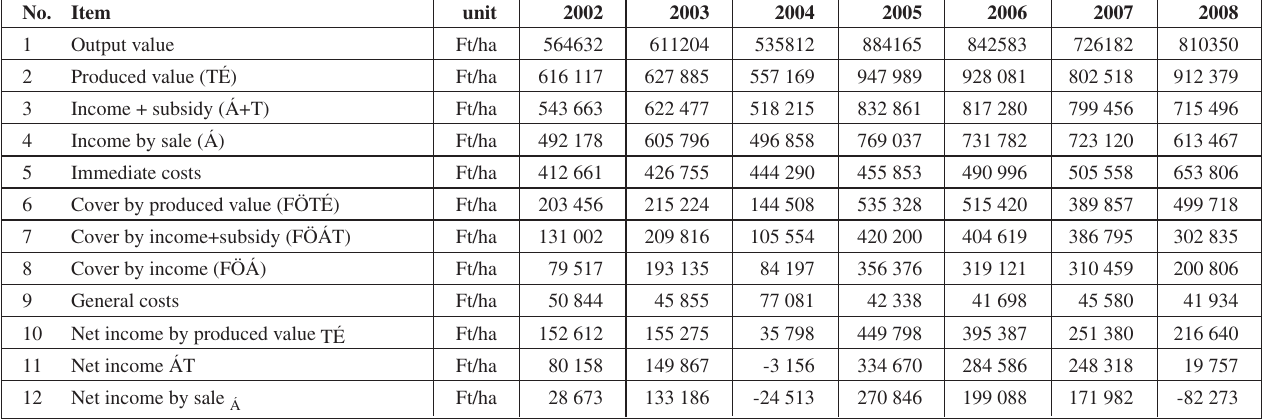
Table 2. The variation of the value produced, the costs and the incomes during